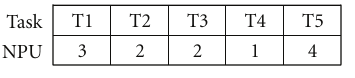
Figure 2: Task placement